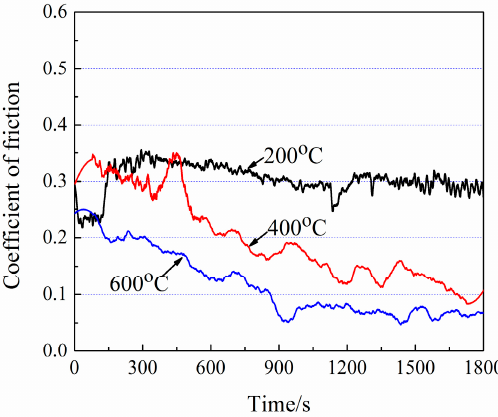
Figure 9. CoF of Si 3 Ni 4 ball/a-Si:H films under different temperatures.